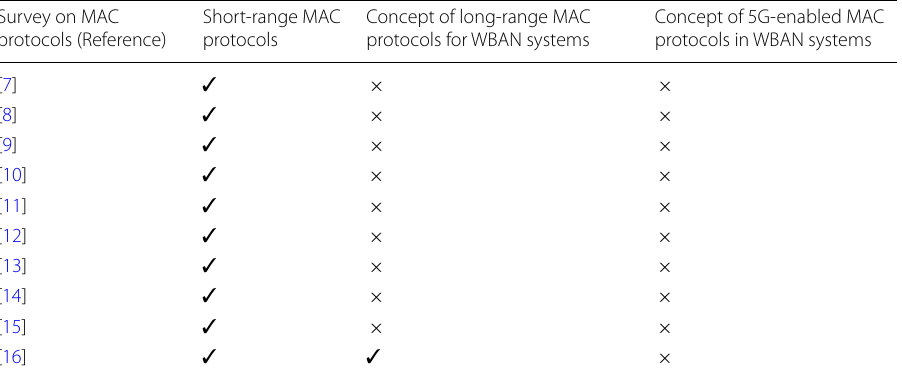
Table 1 Comparison of related survey work on short‑ and long‑range MAC protocols for WBAN